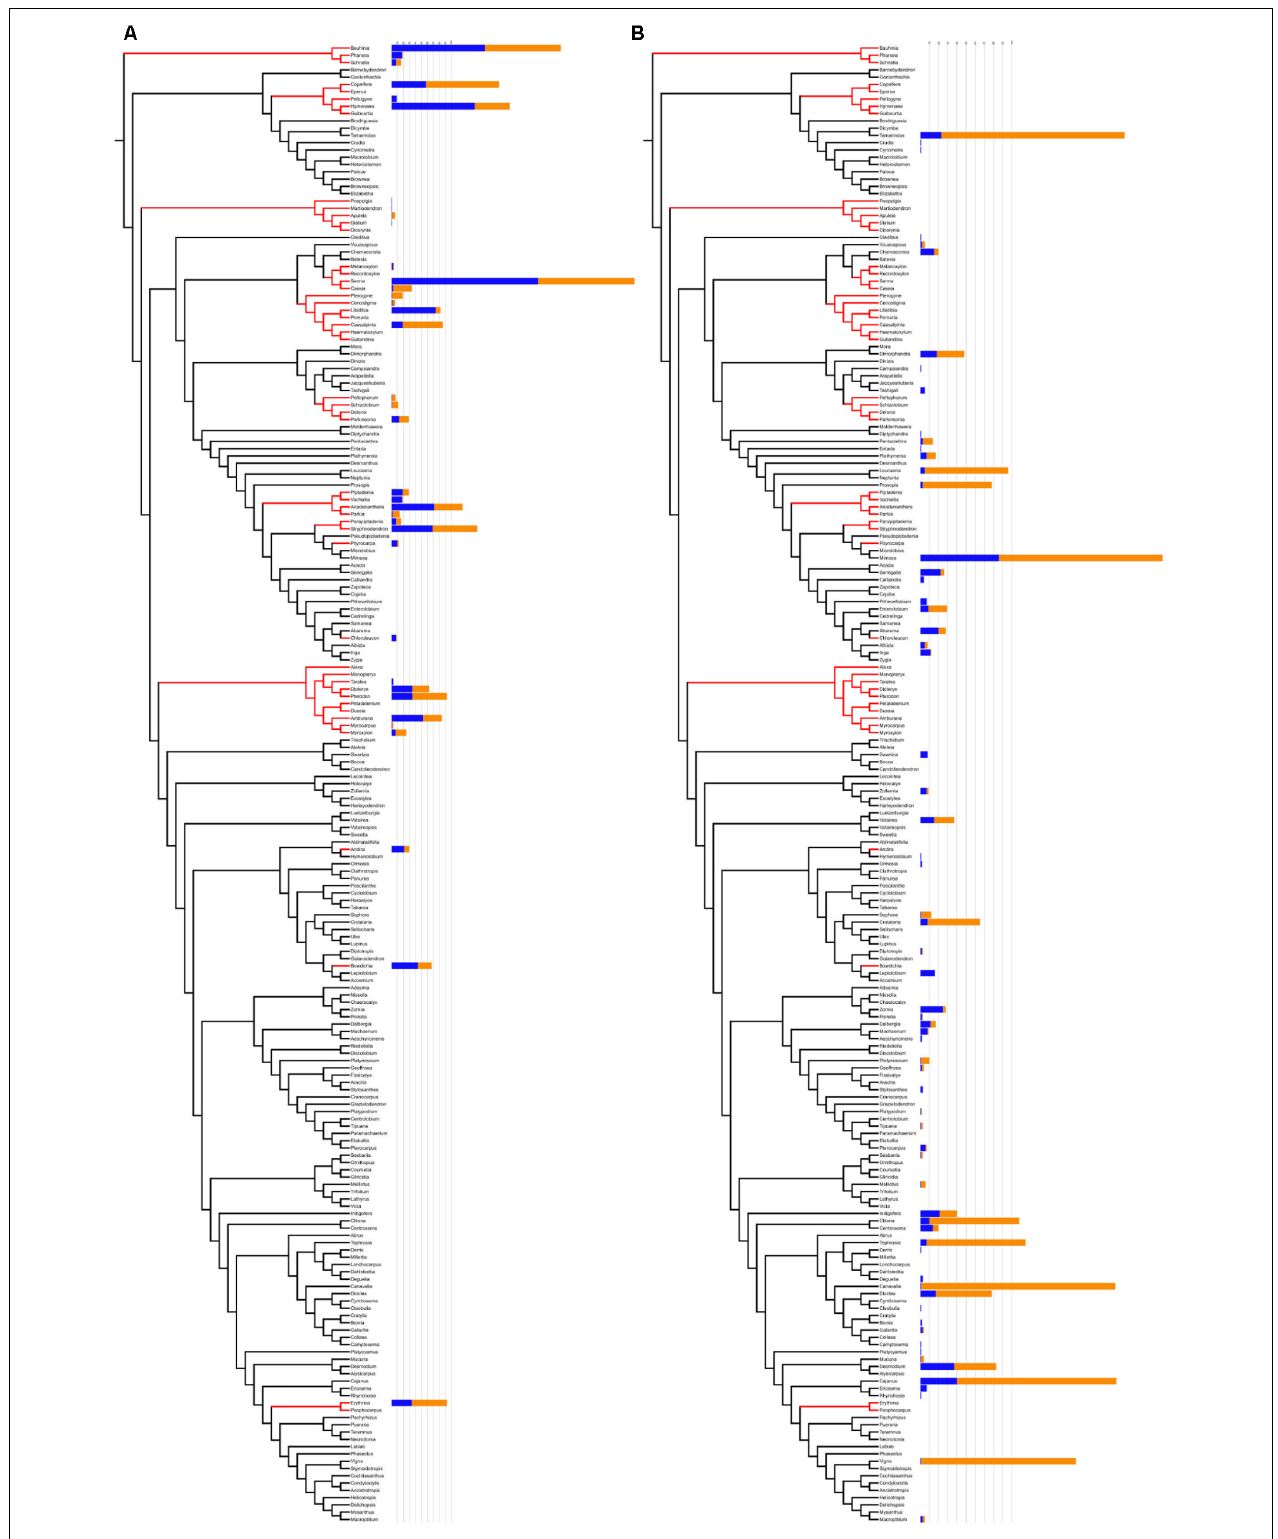
FIGURE 4 | Comparison between hotnode clades (A) and other nodes (B) in relation to number of citations (blue) and number of pharmacological studies (orange). Hotnode clades are calculated based on the distribution of recorded use of species. Species in hotnode clades have significantly more use reports ( p < 0.05).